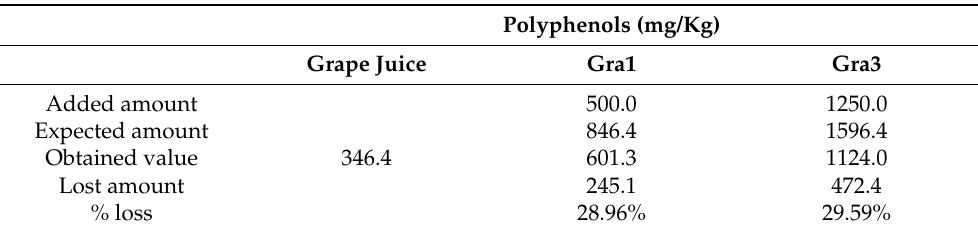
Table 4. Polyphenol levels in grape juice, and in Gra1 and Gra3